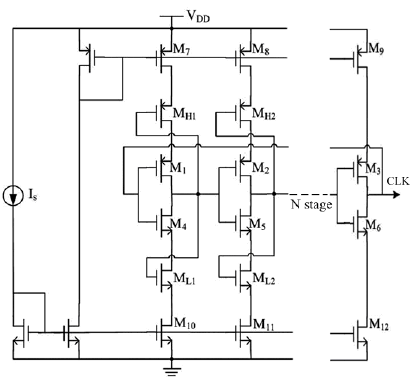
Figure 10. Schematic of the proposed clock generator.